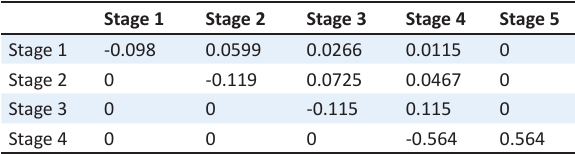
Table 2 . Estimated transition intensities